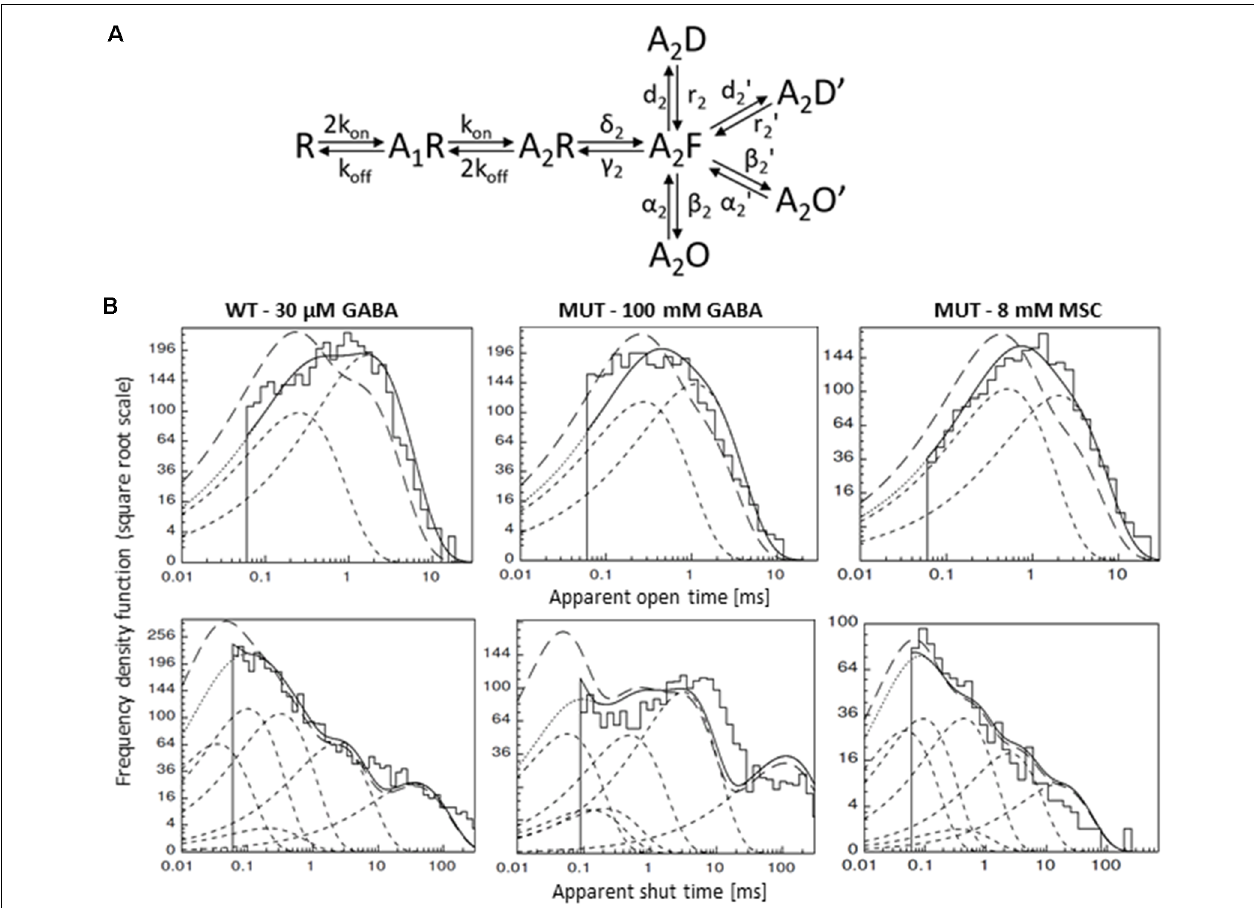
FIGURE 7 | Kinetic model simulations for the single-channel activity. (A) Single-channel kinetic model scheme describing GABA A R states. Model scheme is from Kisiel et al. (2018). (B) Typical dwell-time distributions (top: openings, bottom: closures) for single-channel recordings (left—WT GABA, middle—MUT GABA, right—MUT MSC) with curves showing distributions simulated with rate constants presented in Table 2 : with experimental resolution (solid lines), after correction for missed events (long-dashed lines) and for single transitions (dashed